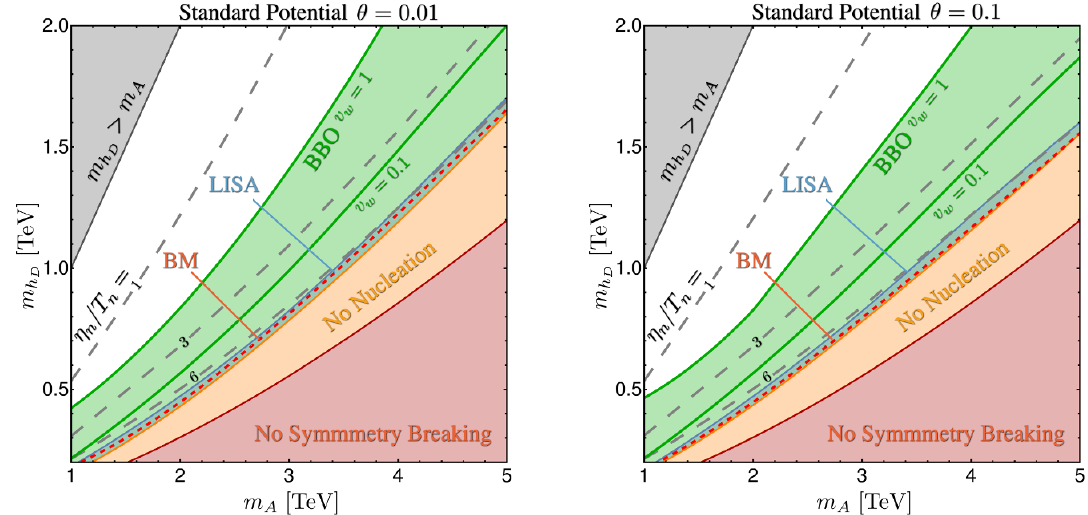
Figure 4 . The parameter space returning a signi(cid:12)cant BBO or LISA signal, SNR > 5, when the symmetry breaking occurs at tree level (standard potential). For LISA we assume v w = 1 as the